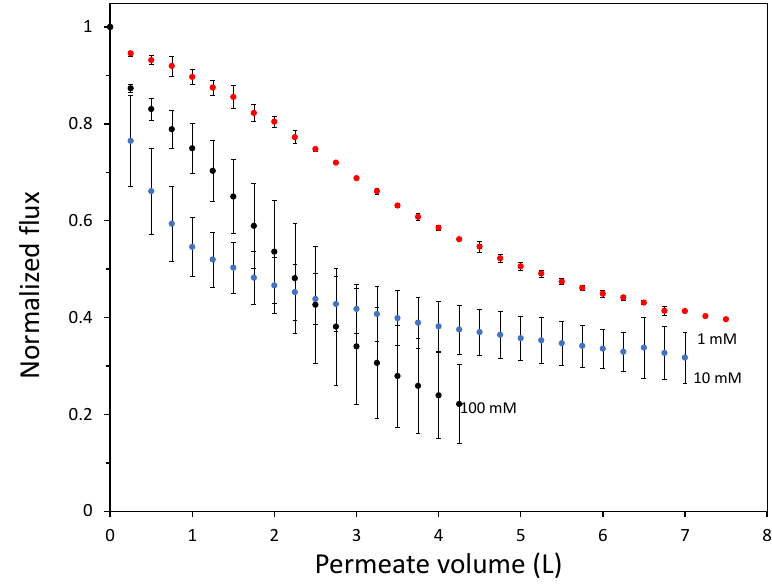
Figure 9. Normalized membrane flux as a function of the permeated volume for different concentrations of NaCl and 463 mg/L SDS. 32 kg/h TMP = 1